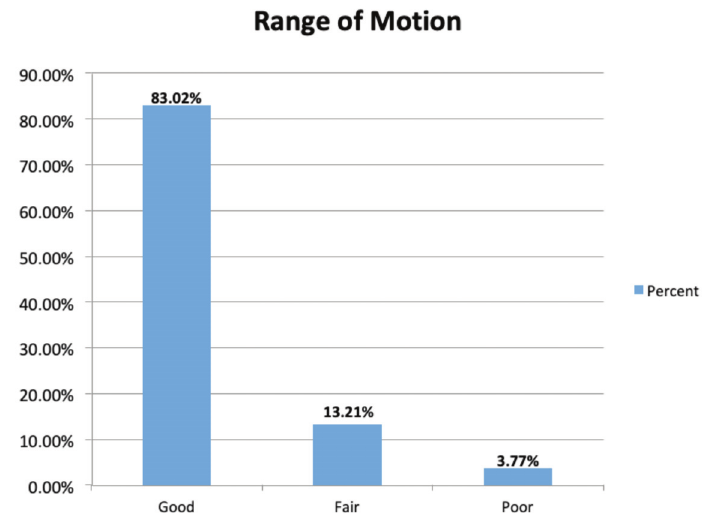
Fig. 3: Demonstrates range of motion after tendon transfer.